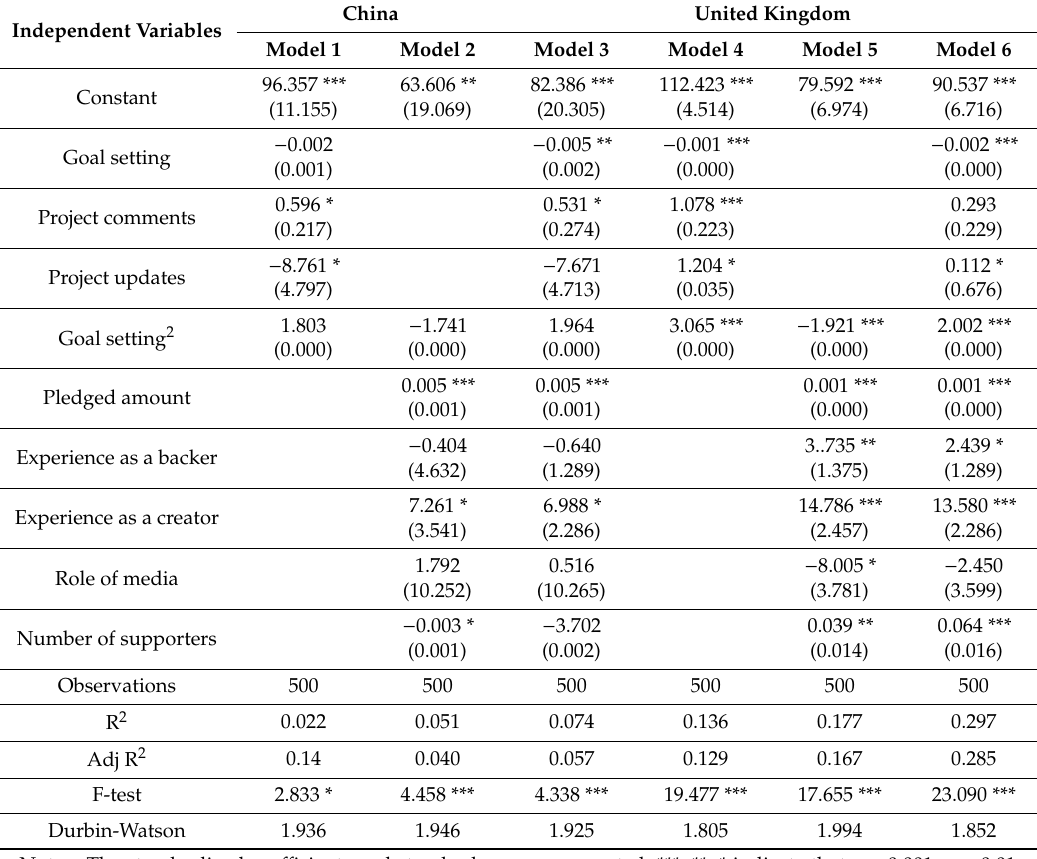
Table 4. Regression results. Outcome variable: project